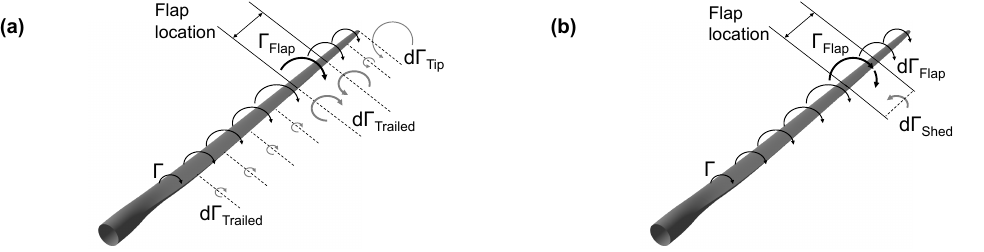
Figure 2. Sketch of the bound circulation along a wind turbine blade with trailing (a) and shed (b) vorticity (part a : Jost et al., 2017).